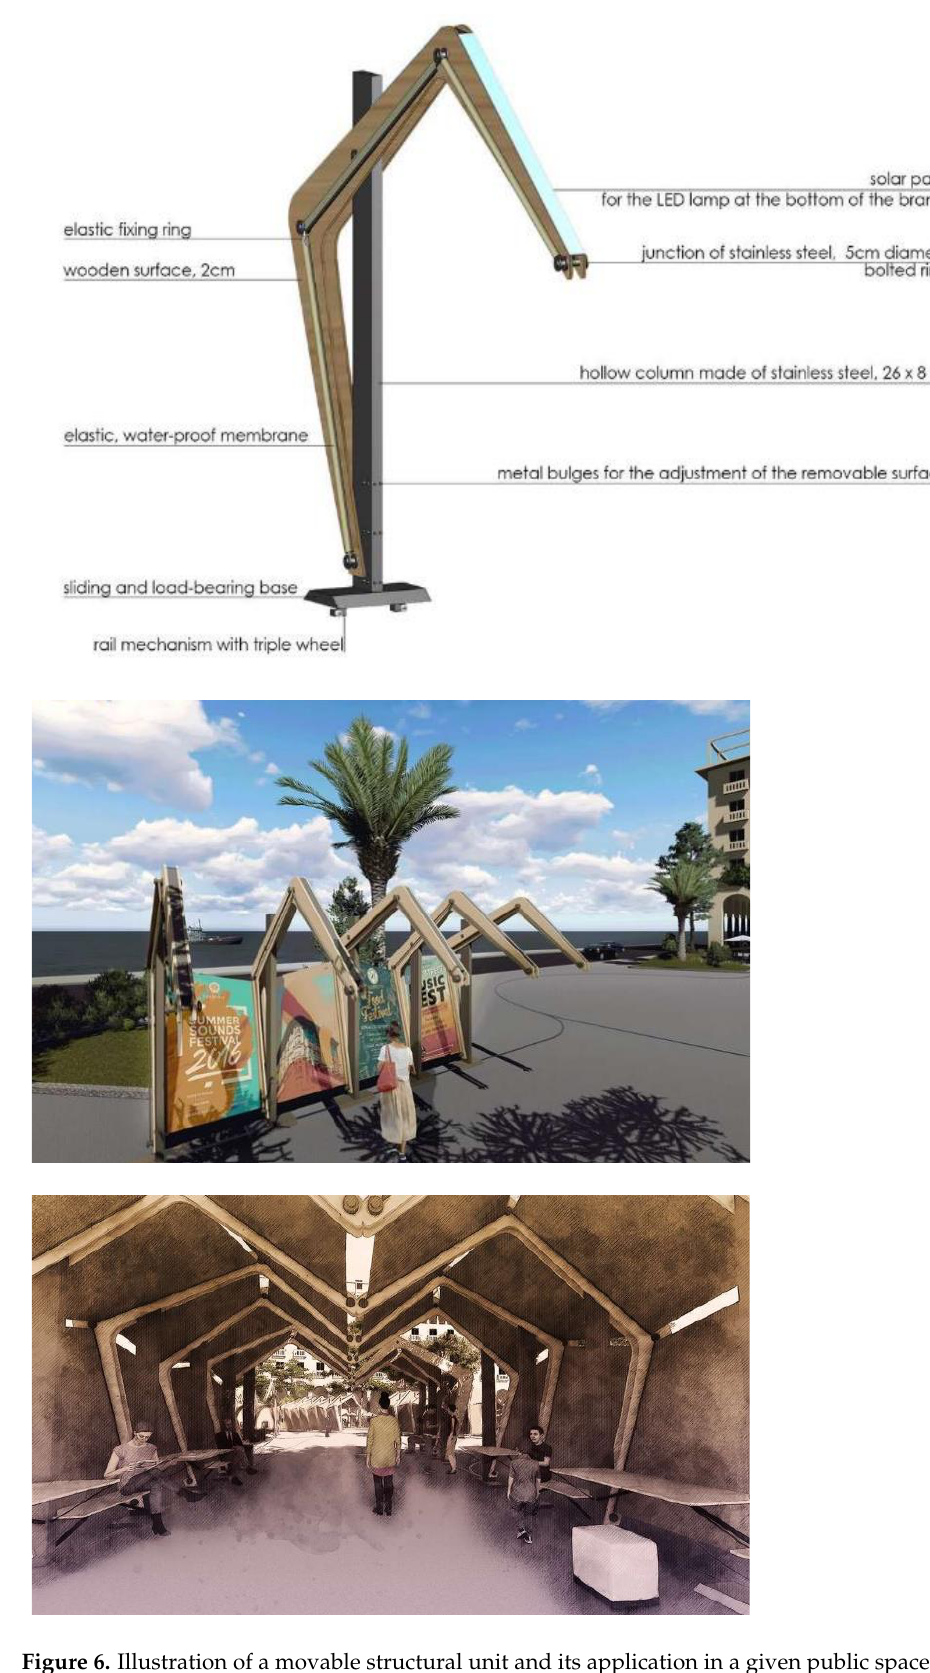
Figure 6. Illustration of a movable structural unit and its application in a given public space [24].